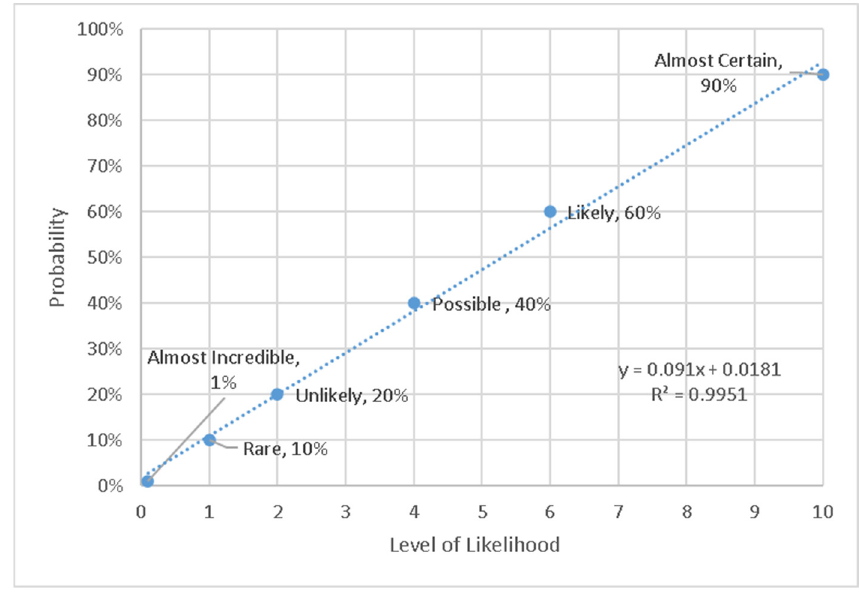
Figure 5. Revised likelihood scale (scale from 0.1 to 10). Table 1. Revised likelihood scale. Table 1. Revised likelihood